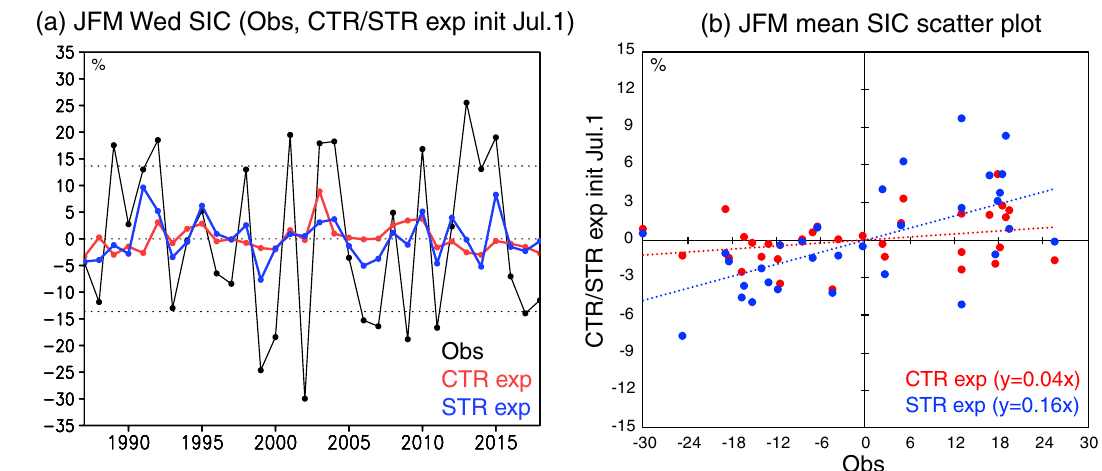
Figure 5. ( a ) Time series of January–March mean SIC anomalies (in % of total surface area) averaged in the Weddell Sea (70° S–60° S, 55° W–40° W; see the black boxes in Fig. 6). The observed anomalies (Obs; black line) and predicted anomalies from July 1st in the CTR (red line) and STR (blue line) experiments are shown, respectively. Dotted horizontal lines indicate positive and negative 0.9 standard deviations of the observed SIC anomalies. ( b ) Scatter plots of January–March mean SIC anomalies (in %) predicted from July 1st in the CTR (red dots) and STR (blue dots) experiments against the observed SIC anomalies averaged in the Weddell Sea. Dotted horizontal lines indicate linear regressions of the predicted anomalies.